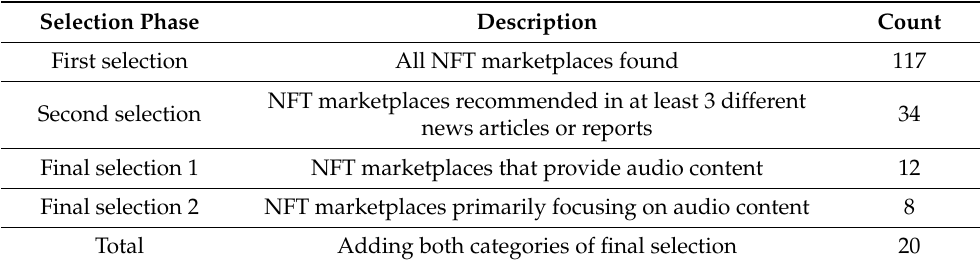
Table 1. Content analysis’ selection